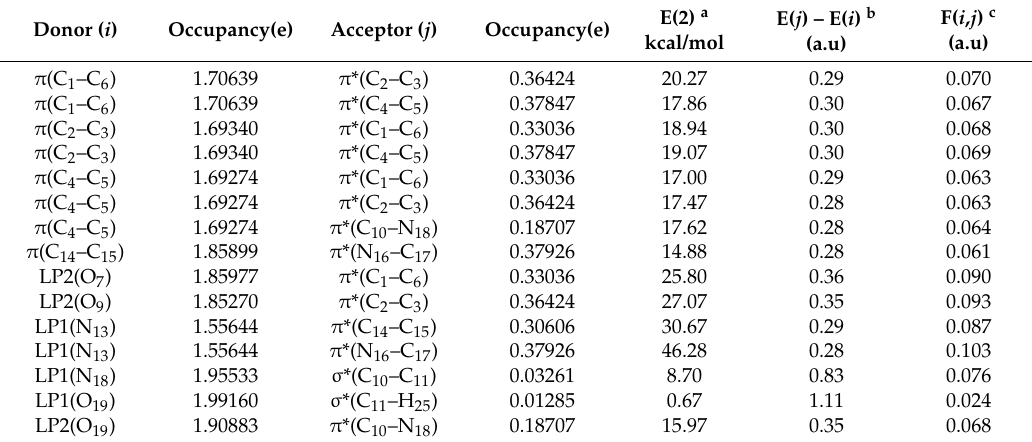
Table 3. Second-order perturbation theory analysis of Fock matrix in natural bond orbital basis for compound 4